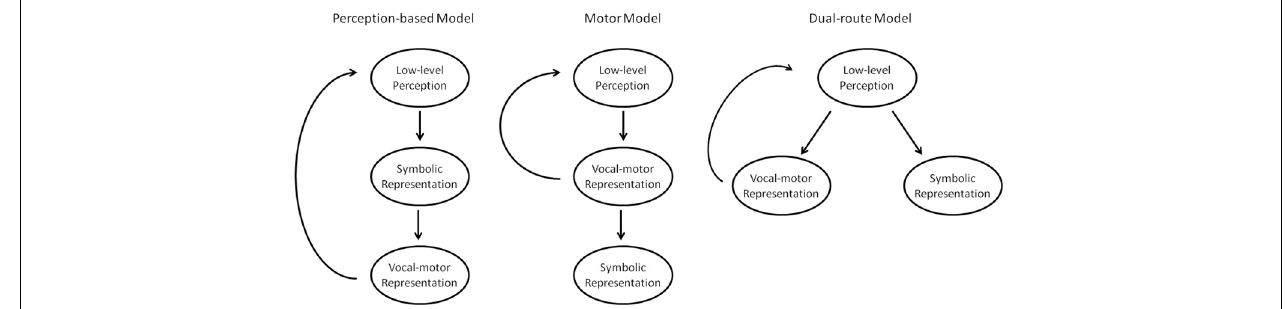
FIGURE 1 | Three proposed models of perception and